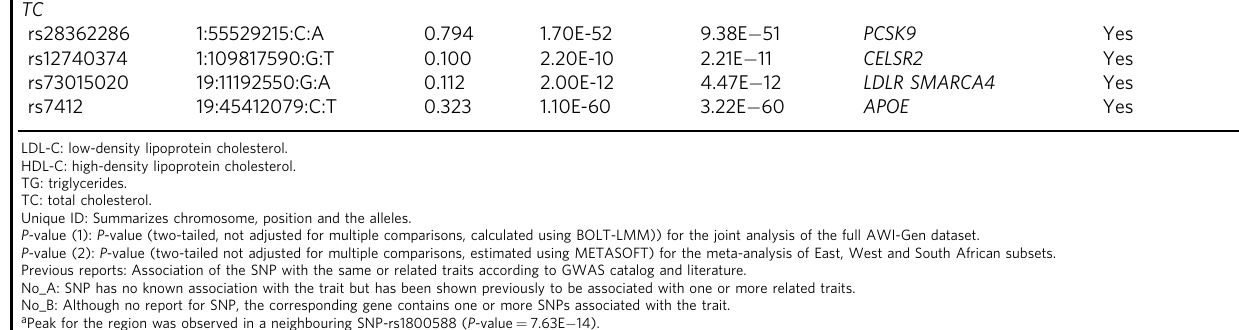
Previous reports: Association of the SNP with the same or related traits according to GWAS catalog and literature. No_A: SNP has no known association with the trait but has been shown previously to be associated with one or more related